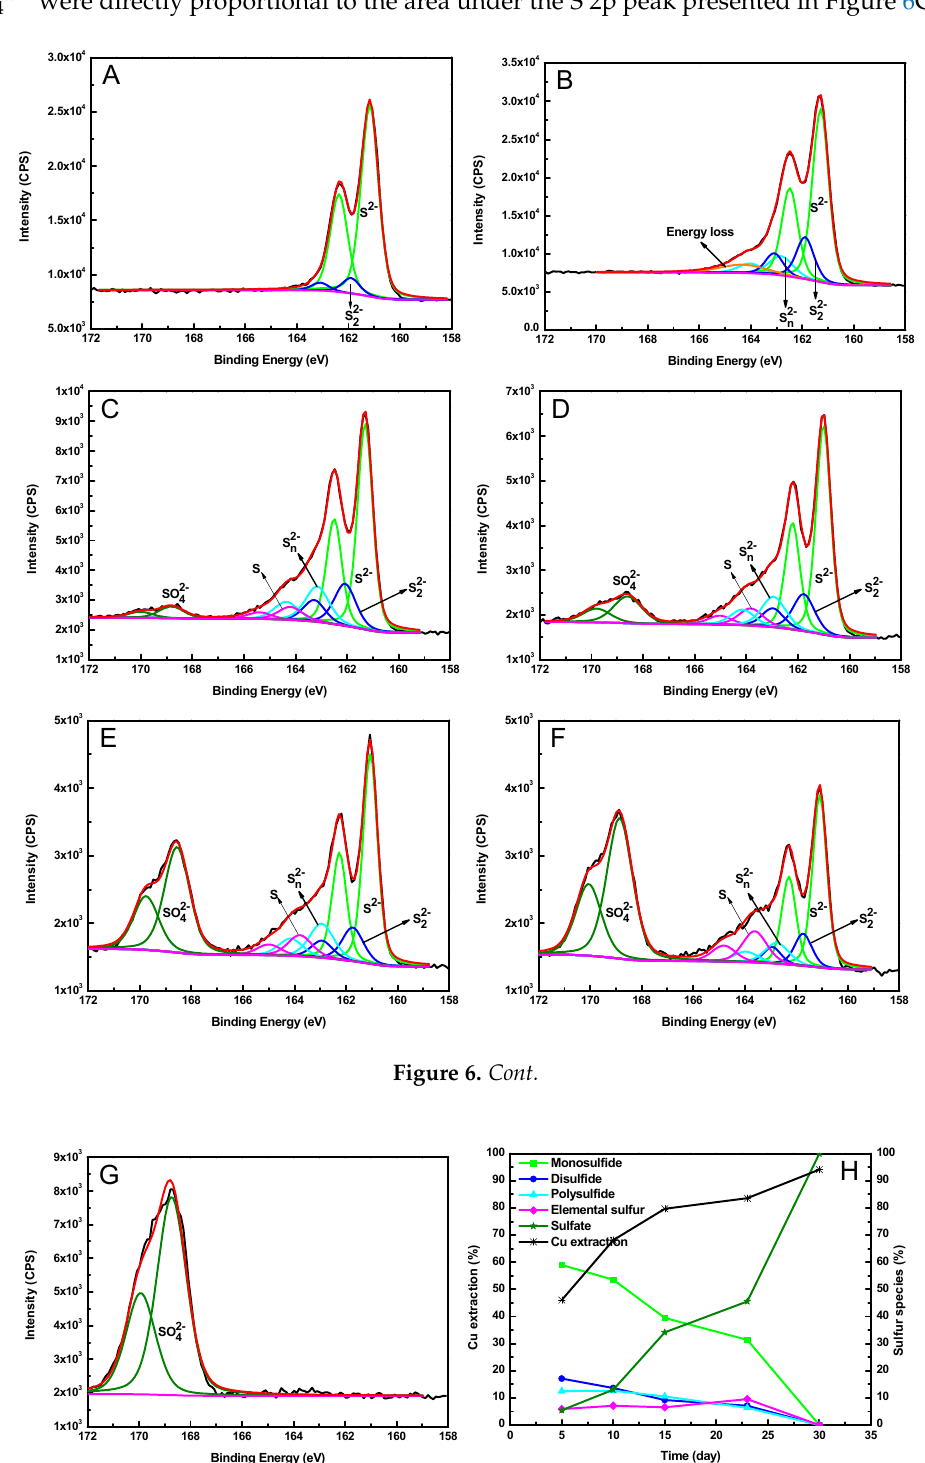
Figure 6. S 2p peaks of co-bioleaching chalcopyrite and bornite (ratio of Ccp/Bn was 3:1). ( A ) bornite; ( B ) chalcopyrite; ( C ) 5 days; ( D ) 10 days; ( E ) 15 days; ( F ) 23 days; ( G ) 30 days; ( H ) Cu extraction and sulfur species on the residue surface. Table 2. Binding energy values for X-ray photoelectron spectroscopy (XPS) spectra of S 2p 3/2 peaks (eV). Condition